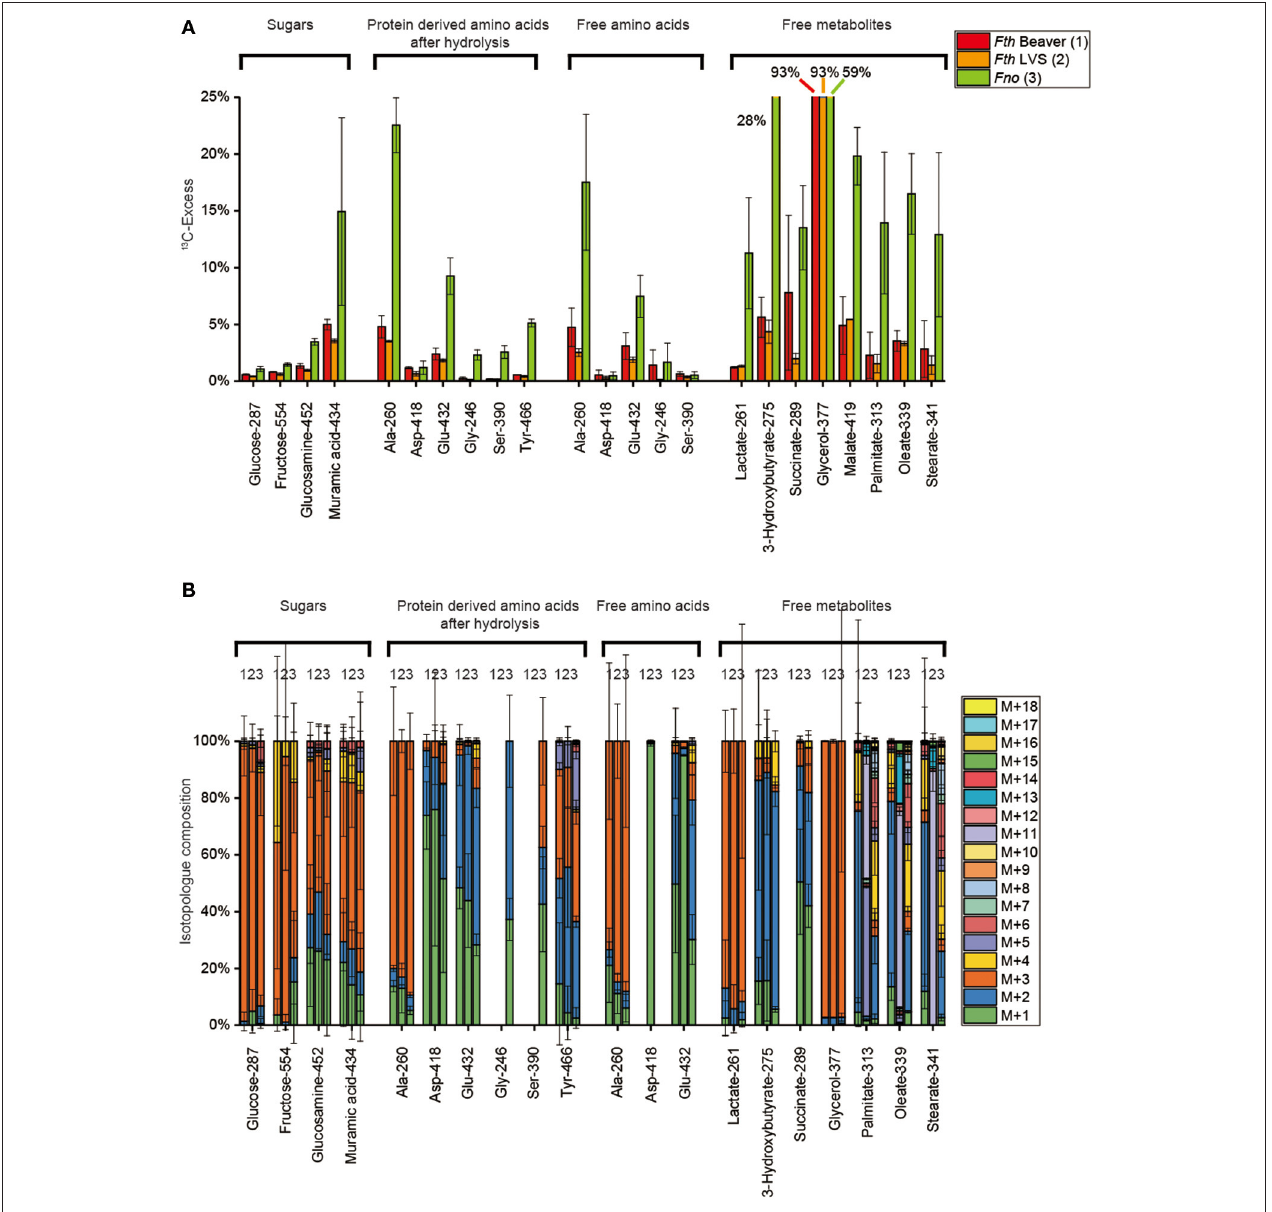
FIGURE 5 | (A) 13 C-Excess (mol%) and (B) the fractional isotopolog distributions (%) in key metabolites of Fth Beaver (1), Fth LVS (2), or Fno (3) grown in medium T supplied with 25 mM [U- 13 C 3 ]glycerol. For numerical values, see Supplemental Tables S4, S8, S12, S16, S20, S24. For more details, see also legend to Figure 2